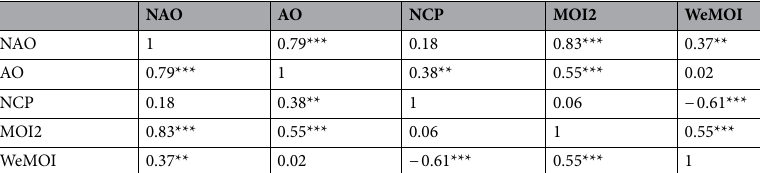
Table 1. Pairwise correlation (Pearson r values) of the January indices of the five atmospheric indices across the years 1950–2019. Significant values are marked with *( p < 0.05), **( p < 0.01), ***( p < 0.001), without correction for multiple